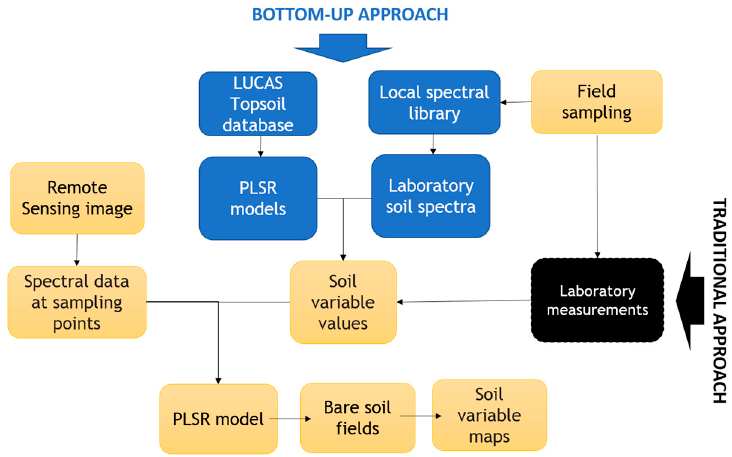
Figure 2. Flow chart concerning the two soil organic carbon (SOC) estimation approaches used in this work: traditional and bottom-up.